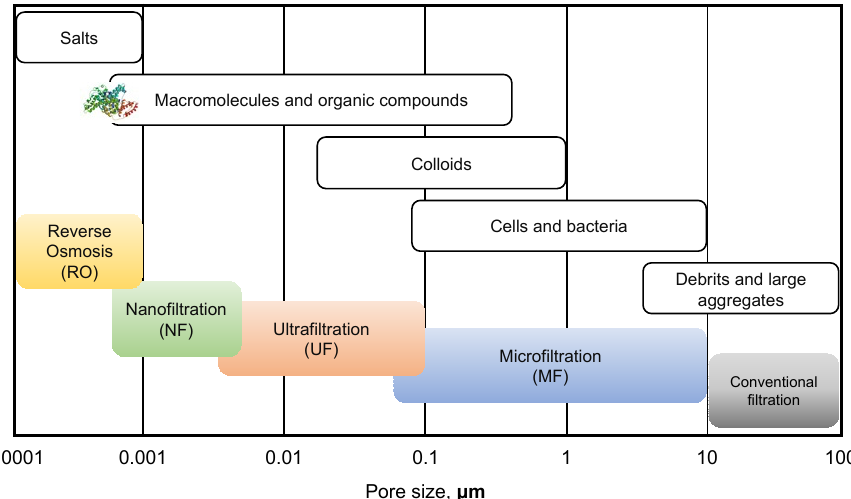
Figure 1. Nominal pore size classification of membrane processes and characteristic dimensions of various common foulants. Despite the categorization, upper and lower size limits usually overlap between two adjacent processes due to pore size distributions. The figure also shows the most suitable process for each foulant category.